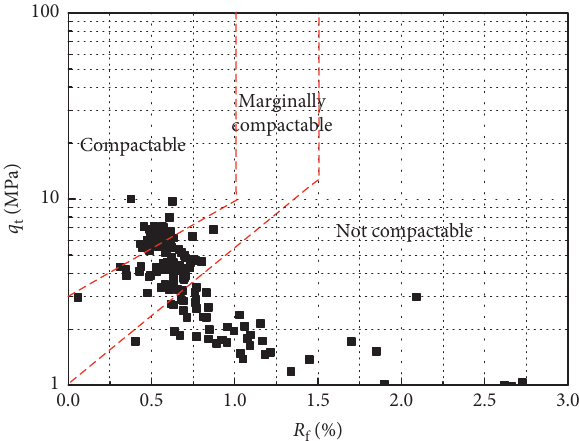
Figure 8: Compact ability evaluation based on the Massarsch method.